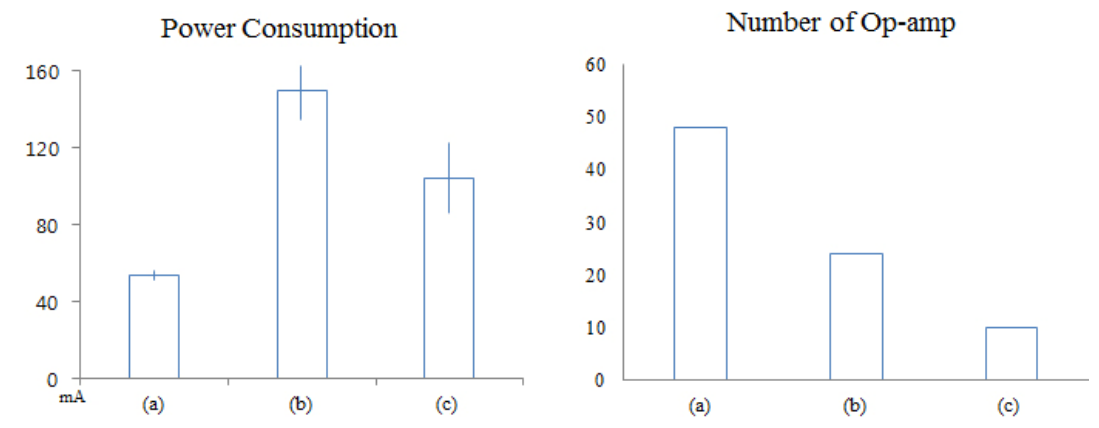
Figure 11. Comparison of power consumption ( left ) and Number of Op-amp ( right ): ( a ) 8 channels EEG sensor platform using Zigbee communication; ( b ) Previous 4 channels multi-body sensor platform using Bluetooth communication; ( c ) Enhanced 4 channels multi-body sensor platform using Bluetooth